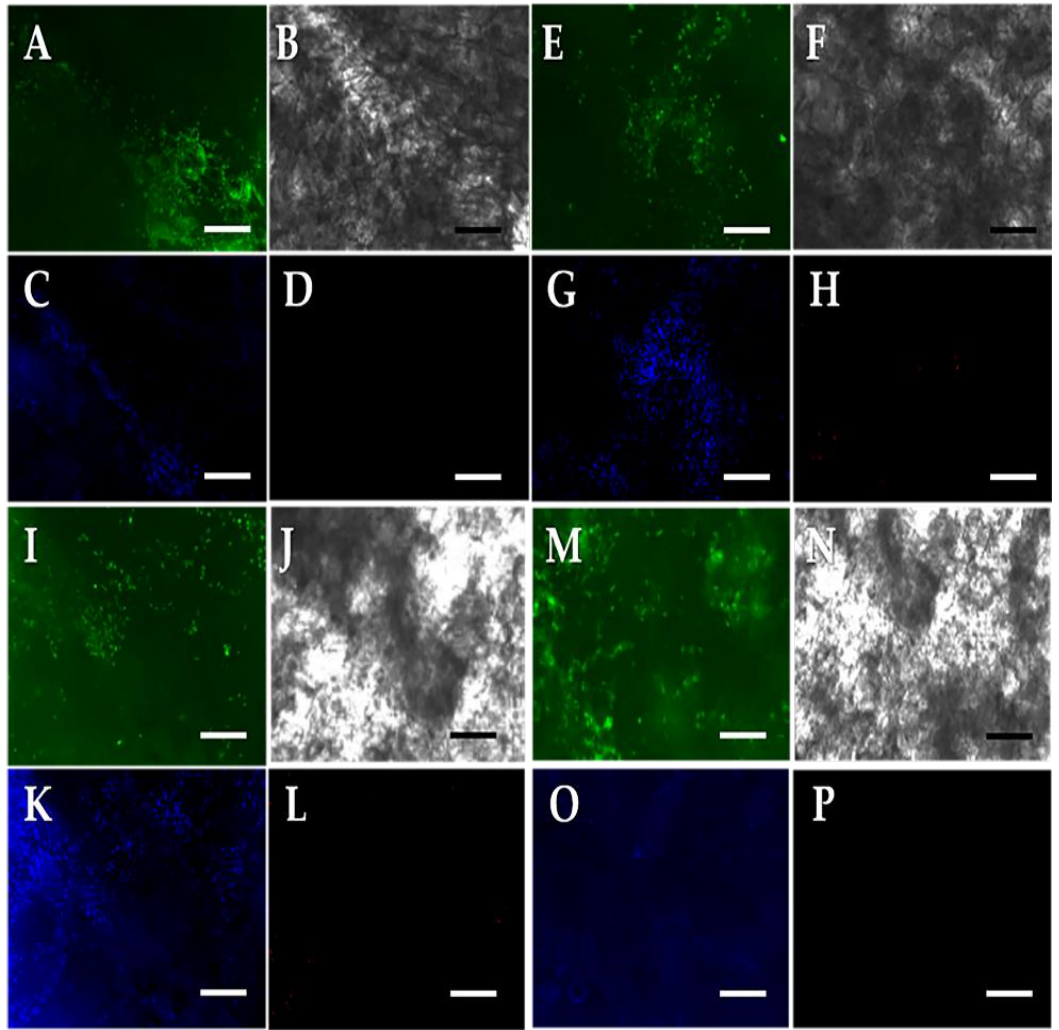
Figure 8. Confocal micrographs of a representative slice of scaffold crosslinked with EDC/NHS into which chondrocytes had been seeded on the top of surface. ( A ) Living cells, which appear in green, ( B ) scaffold structure, ( C ) cells stained with DAPI, and ( D ) dead cells, which appear in red — three days in. The letter sequences have the same significance as ABCD but changed with evaluation time: ( E – H ) for 7 days, ( I – L ) for 10 days, and ( M – P ) for 14 days. Micrographs with glutaraldehyde not shown due to interference of the structure. Bar = 200 µm.